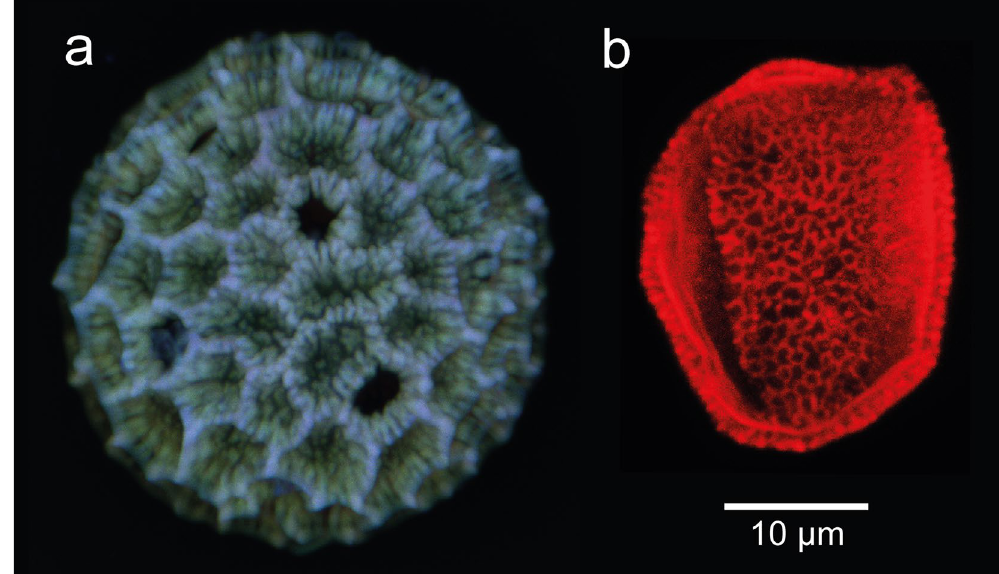
Figure 2. Confocal laser microscope images of pollen grains from sediment adhering to the Clacton bone tools. ( a ) Persicaria maculosa , ( b ) Type X. The colour in both images is an artefact of the imaging process. See Supplementary Information for pollen analysis details.